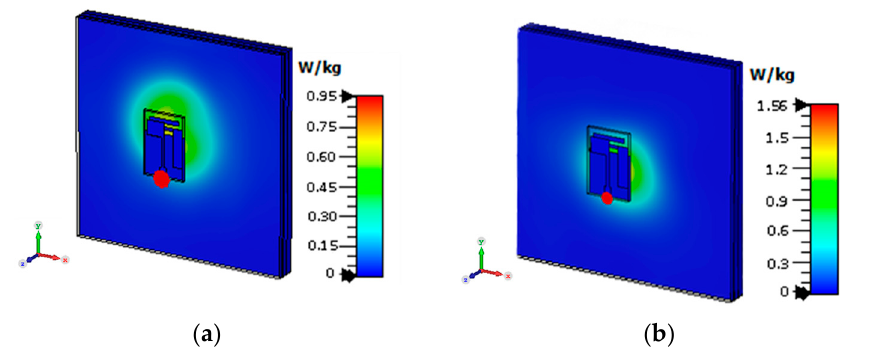
Figure 20. SAR of the antenna: ( a ) at 2.45 GHz; ( b ) at 5.8 GHz.